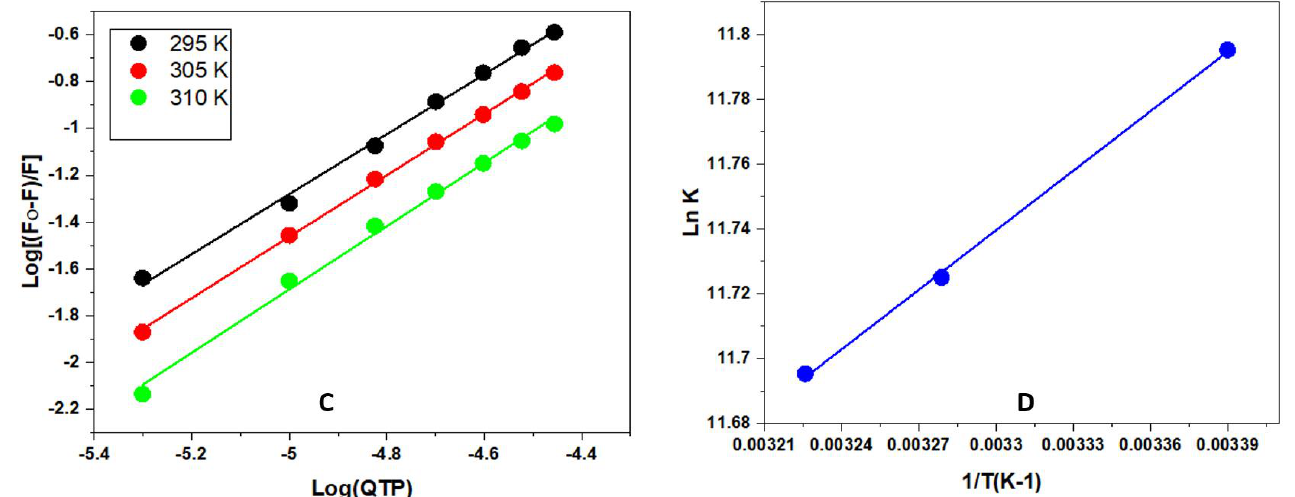
Figure 3. ( A ) Steady-state fluorescence emission spectra of HSA were recorded in the absence and presence of increasing concentrations of QTP. The intrinsic fluorescence of the HSA was measured at 295 K in the wavelength range of 300 – 420 nm after exciting at 295 nm. The black arrow represents fluorescence quenching of HSA on titration with QTP ( B ) Stern-Volmer plot for QTP-HSA interaction (295, 300, 310 K). ( C ) Double log plot for the QTP-HSA interaction at different temperatures (295, 300, 310 K). ( D ) van ’ t Hoff plot (lnK vs. 1/T) for the binding of QTP to HSA. The concentration of